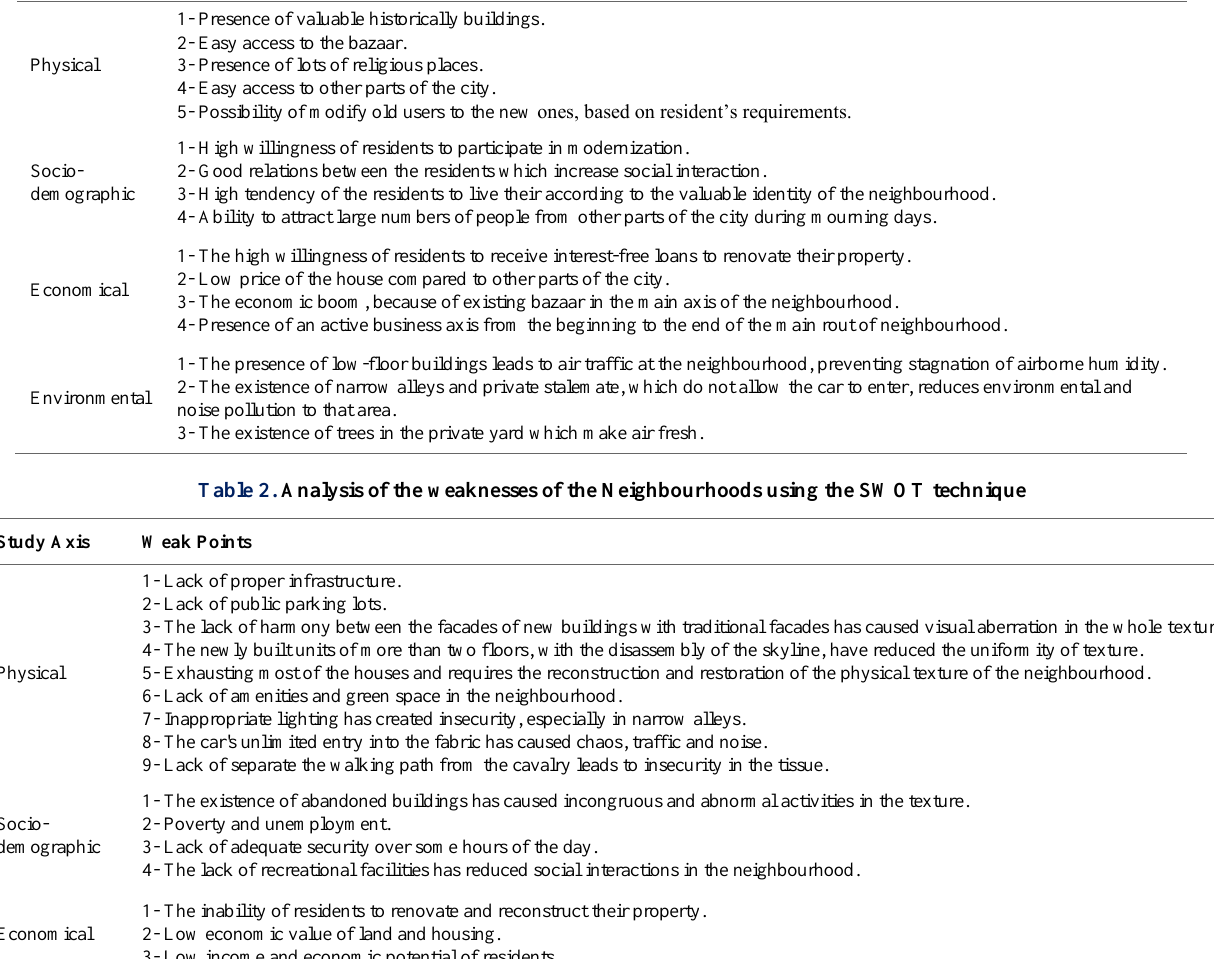
Table 1. Analysis of the strengths of the Neighbourhoods using the SWOT technique Study Axis